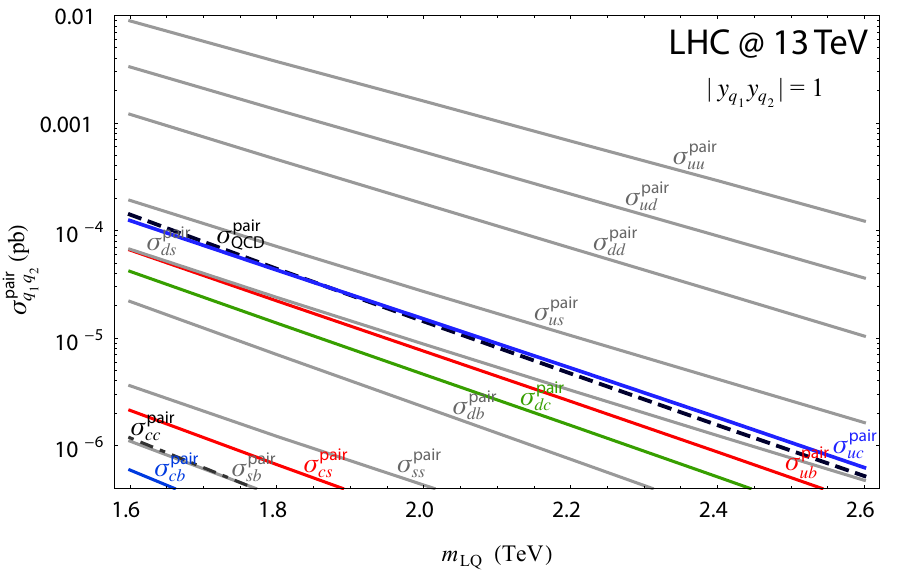
( y ) for quark- q 1 , y q 2 , m LQ q 1 q 2